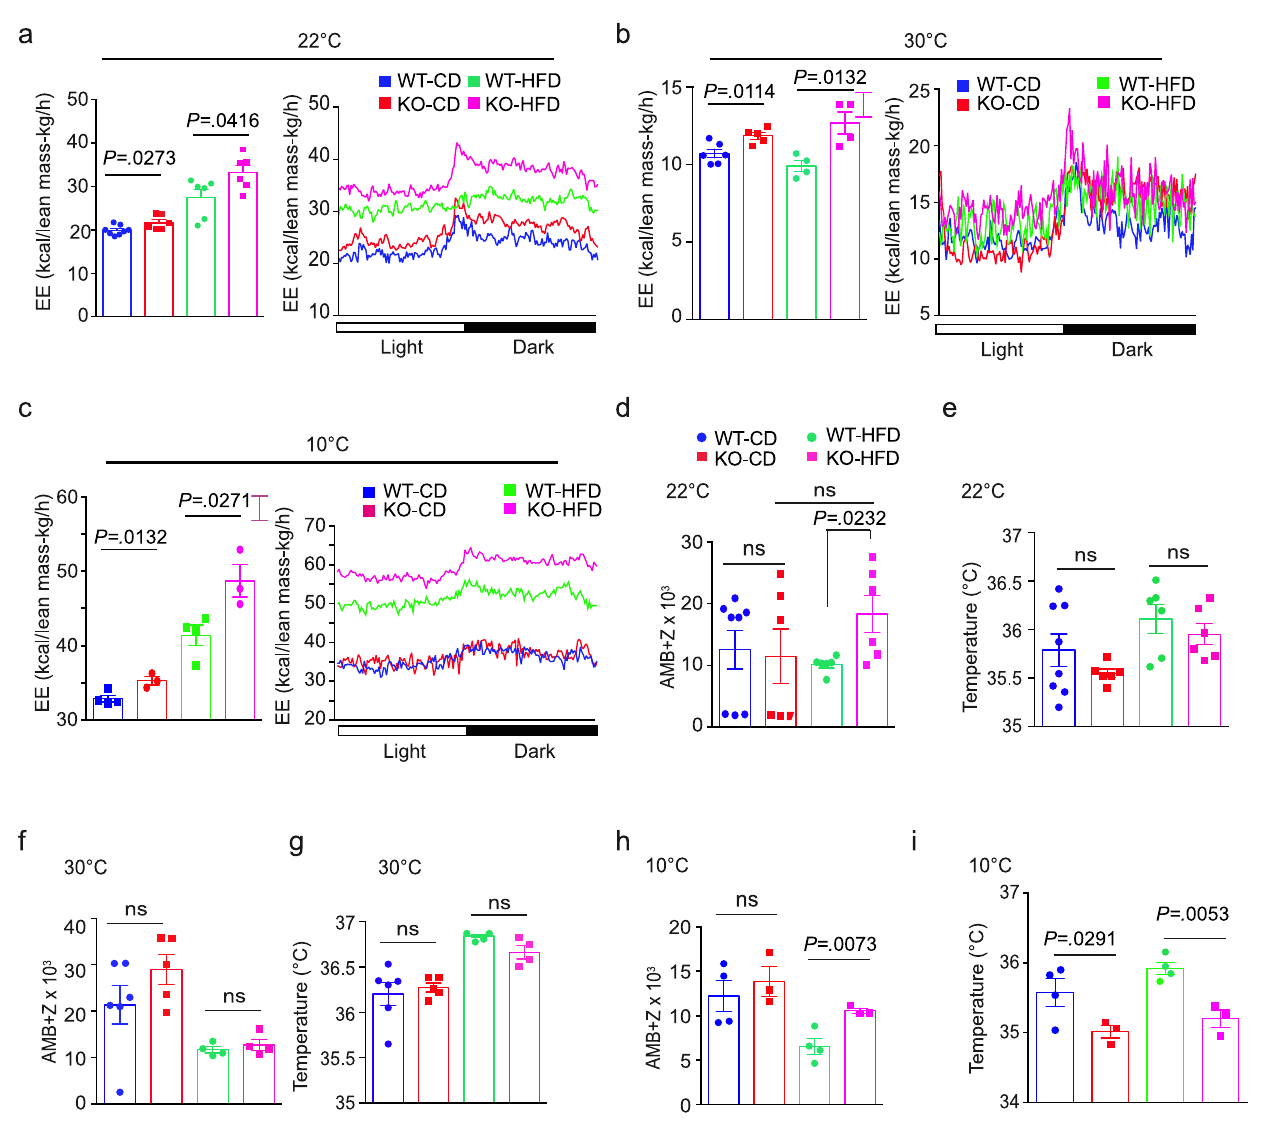
values collected over 4 days at 22°C ( n : WT-CD, 8; KO-CD, 6; WT-HFD, 6; KO-HFD, 6). f Physical activity measured by beam breaks, or g , temperature, showing mean values collected over 4 days at 30°C ( n : WT-CD, 6; KO-CD, 5; WT-HFD, 4; KO-HFD, 4). h Physical activity measured by beam breaks, or i temperature, showing mean values collected over 5 days at 10°C ( n : WT-CD, 4; KO-CD, 3; WT-HFD, 4; KO-HFD, 3). Data are presented as mean±s.e.m.; signi fi cance is assessed by unpaired two- sided Student ’ s t -test. Data are representative of three similar experiments. n = number of biologicallyindependent animals. Sourcedata are provided as aSource Data fi